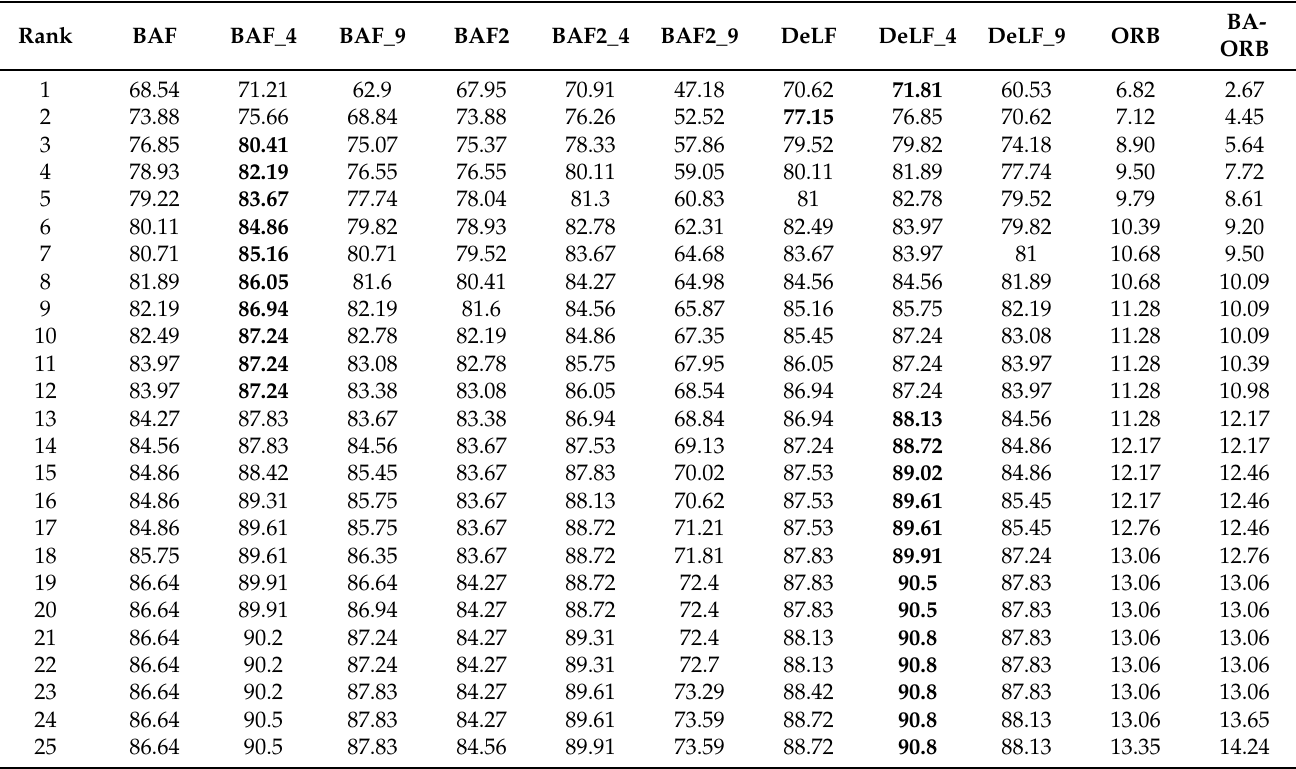
Table 6. Recalls of experimental